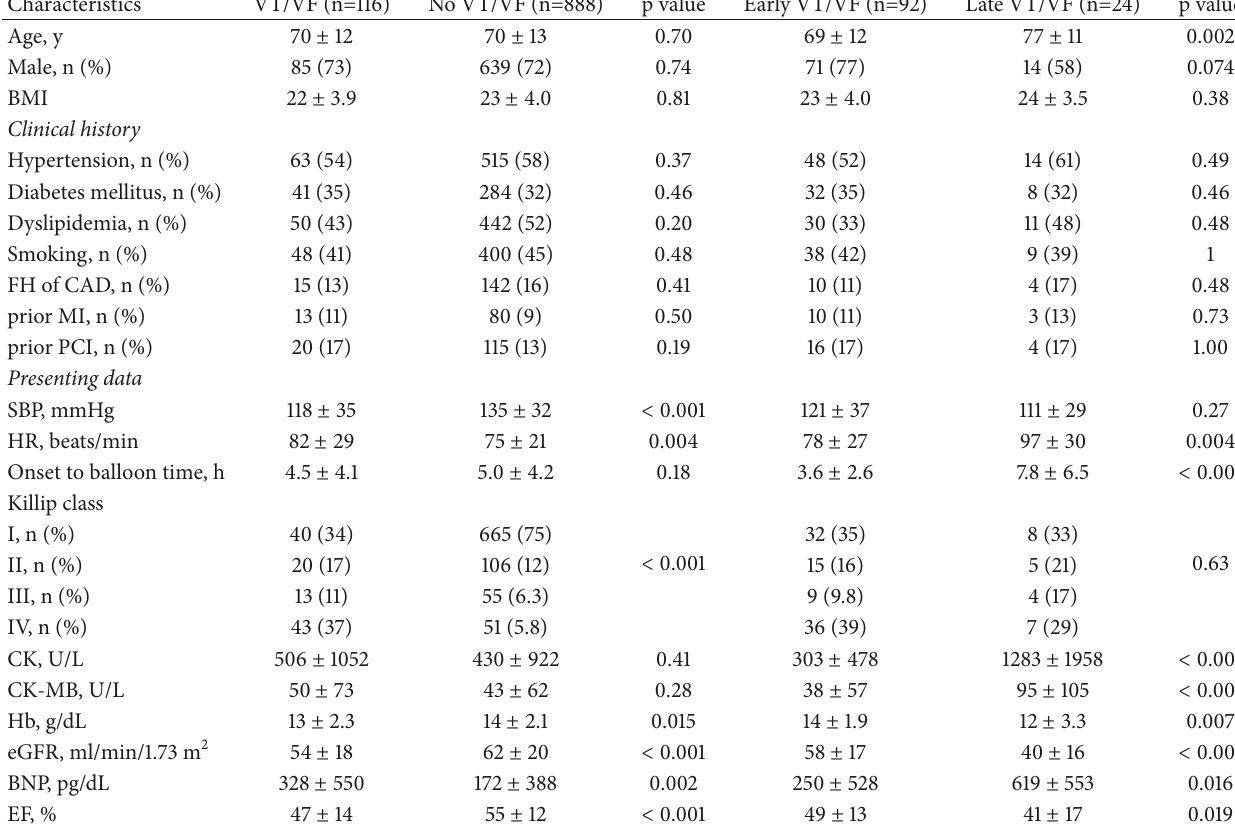
Table 1: Baseline characteristics of the patients with VT/VF or no VT/VF and early VT/VF or late